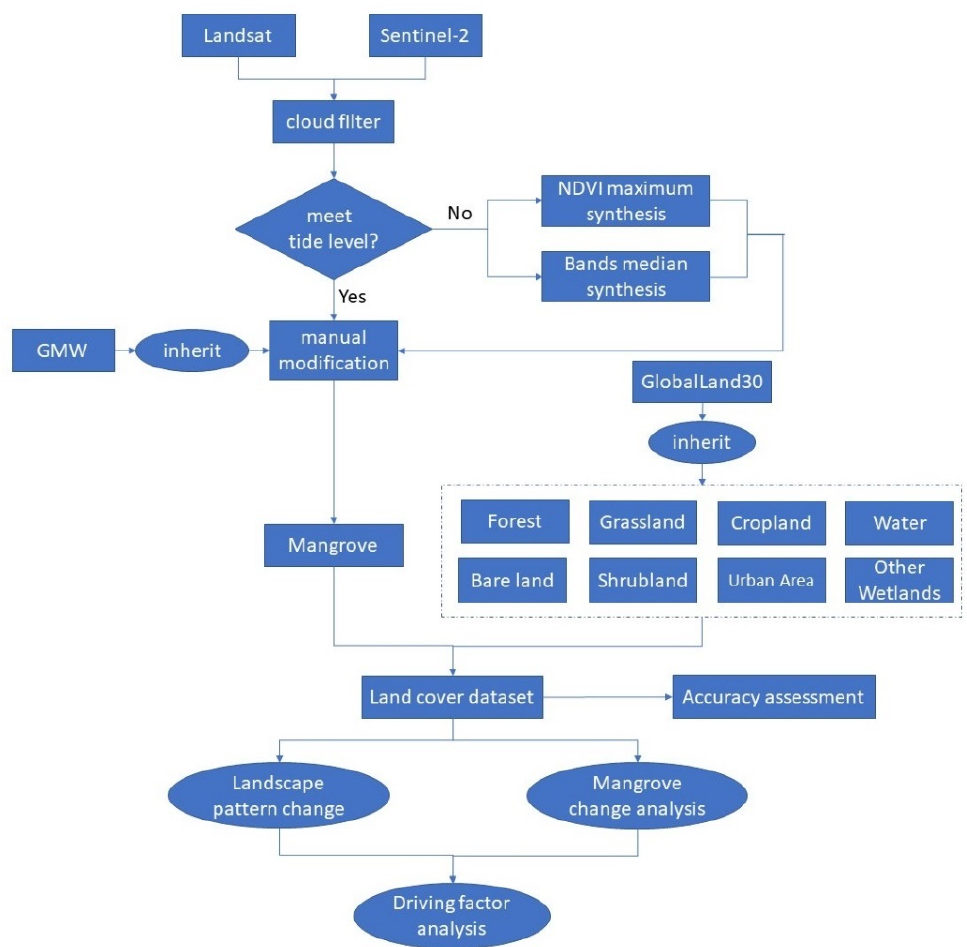
Figure 2. Flow chart of data collection and analysis procedures.